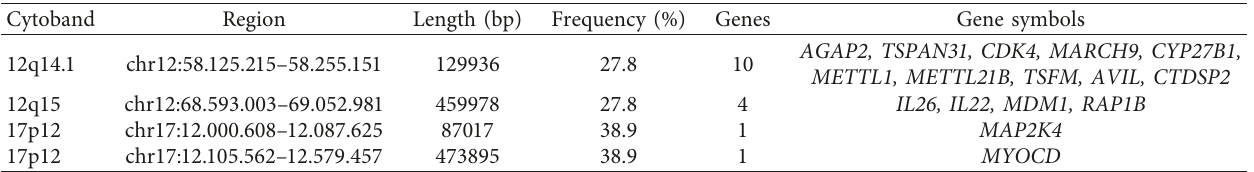
Table 1: Recurrent high copy gains in leiomyosarcoma samples analysed by OncoScan. Cytoband location as well as DNA base range according to human genome assembly GRCh37 is annotated. The event frequency and lists of genes in the corresponding region are